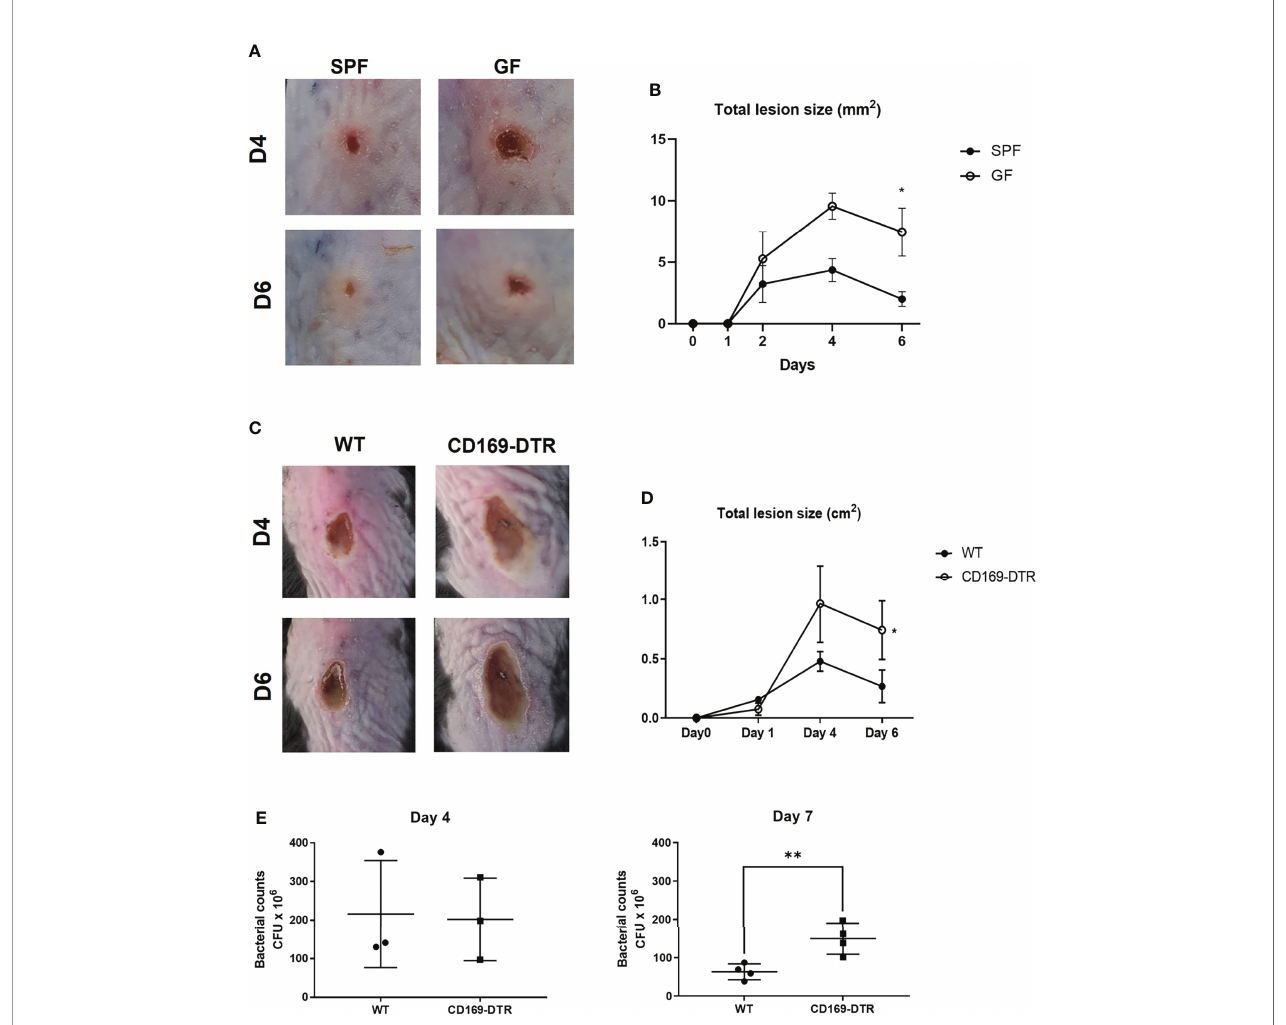
FIGURE 4 | Impairment of immune response in germ-free and CD169 + cell-de fi cient mice against Staphylococcus aureus skin infection. (A) SPF and GF mice (n = 3 per group) were intradermally challenged with 2×10 7 CFUs of CA-MRSA (USA300). Representative pictures of skin lesions on day 4 (D4) and day 6 (D6) post infection. (B) Total lesion size of SPF and GF mice (n = 3 per group) over-time calculated by ImageJ program. The Images and data represent two independent experiments. (C) Representative pictures of skin lesions in WT and CD169-DTR mice (n = 3 per group) after intradermal S. aureus infection on D4 and D6 post infection. (D) Total lesion size of WT and CD160-DTR mice over-time. The Images (C) and data (D) represent three independent experiments. (E) CFU counts in skin lesion homogenates of WT and CD169-DTR mice after S. aureus intradermal infection on day 4 (n = 3 per group) and day 7 (n = 4 per group). Data represent three independent experiments. Data are expressed as means ± SEM (*p < 0.05, **p <